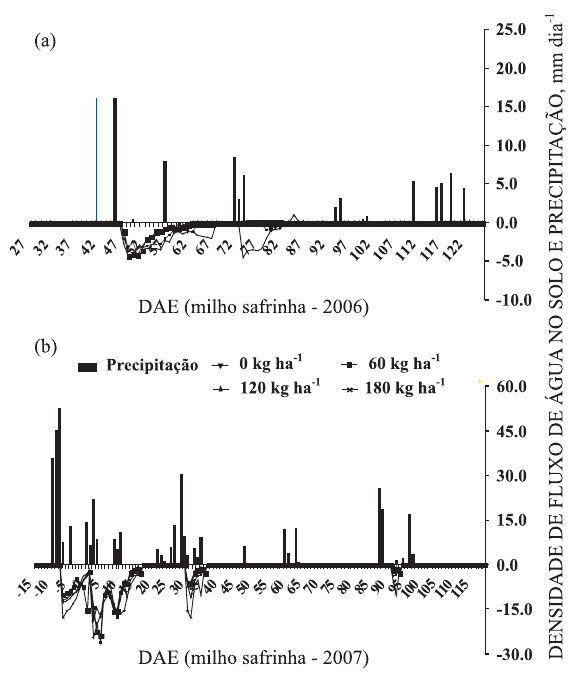
Figura 2. Densidade de fluxo de água e precipitação pluvial em função do tempo (DAE = dias após a emergência), na cultura de milho safrinha, ano 2006 (a) e 2007 (b), nos tratamentos 0, 60, 120 e 180 kg ha -1 .